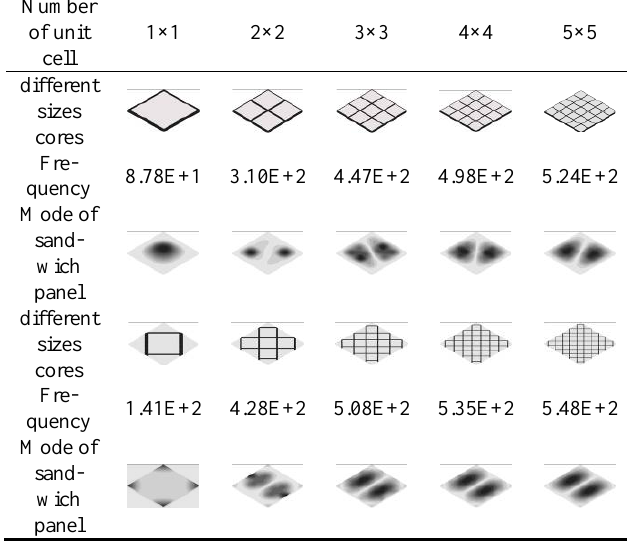
Tab 15. The second orde vibration re le r sponse with th re a different size squa nd rho bic cores